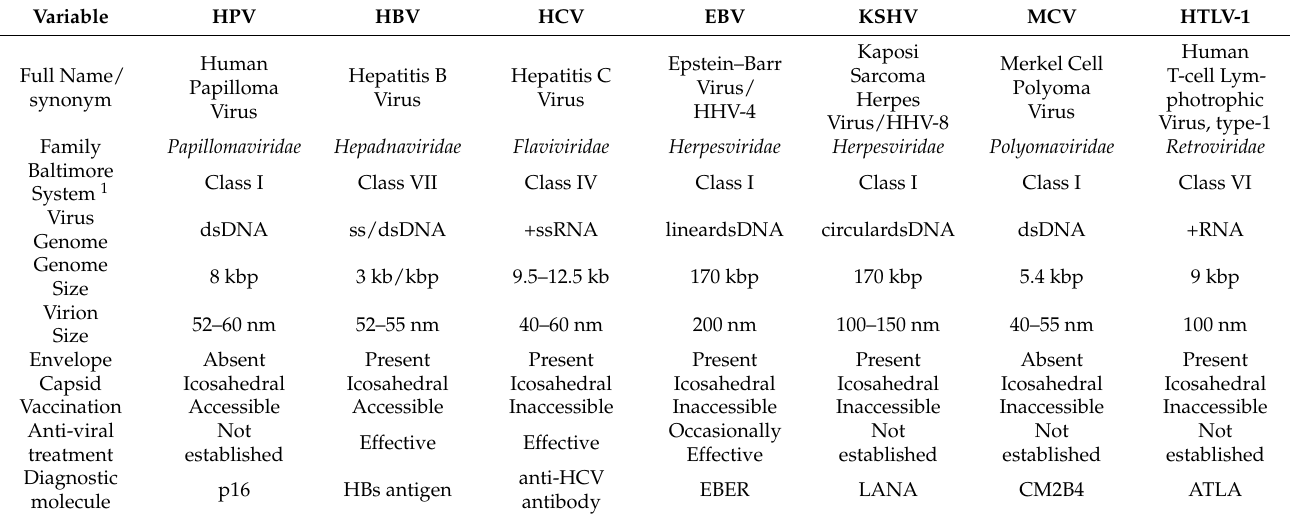
Table 1. Summary of human tumor